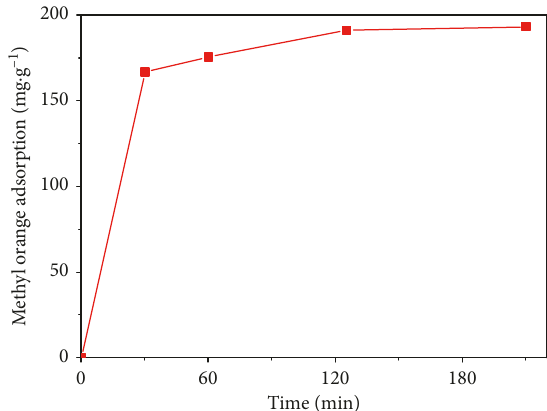
Figure 12: Effect of contact time on the methyl orange